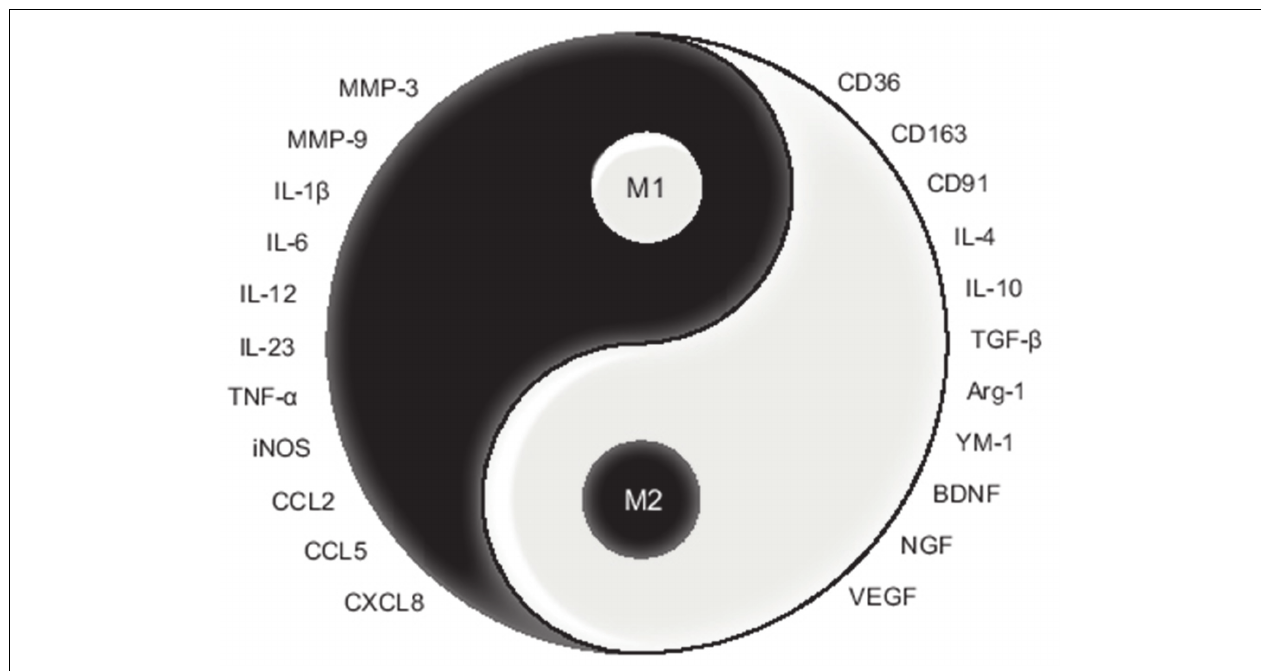
FIGURE 2 | Sketch map for the opposite function of M1/M2 microglia. In this Tai Chi-diagram, the half-filled-out symbols with left half black represent M1 microglia, with the expression of MMPs, pro-inflammatory cytokine, and chemokine. And the right half white represents M2 microglia, with the expression of phagocytic receptors, anti-inflammatory cytokine, and growth